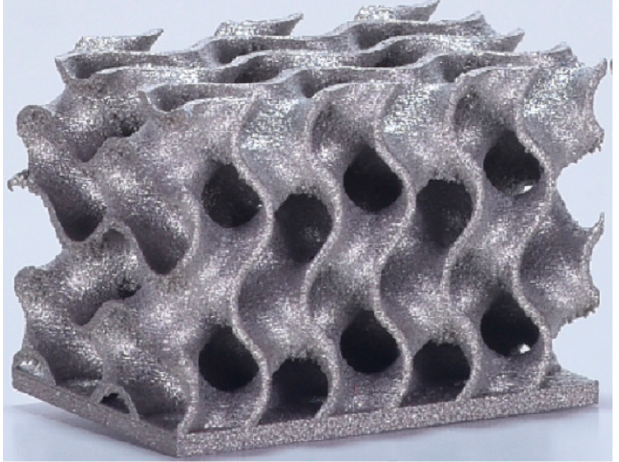
Figure 6. View of the gyroid structure made using the AM method for the study of heat transfer under forced convection conditions [83].